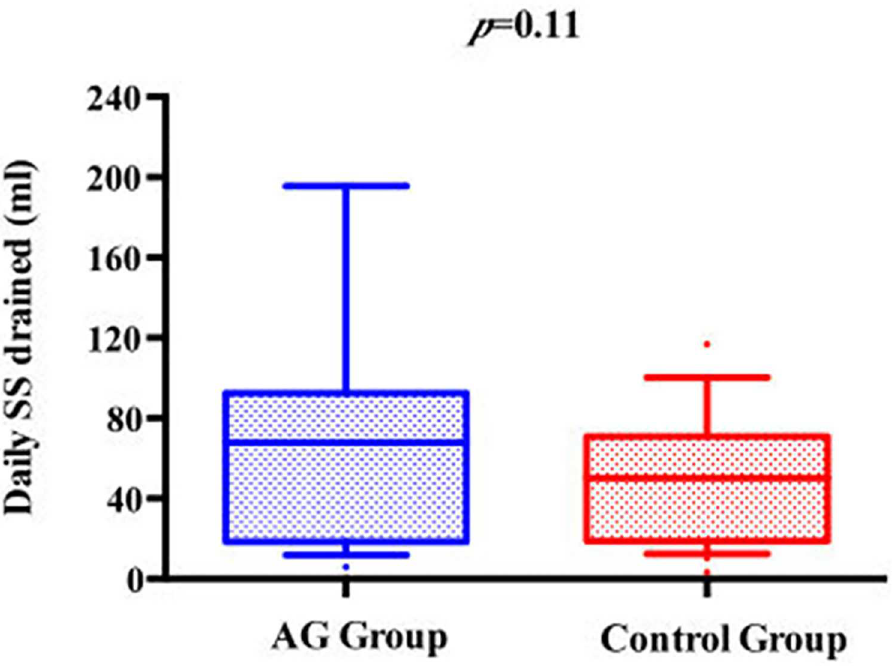
Fig 3. Comparison between AG group and control group according to daily SS drained. AG , Anapnoguard; P cuff , Cuff Pressure; SS ,